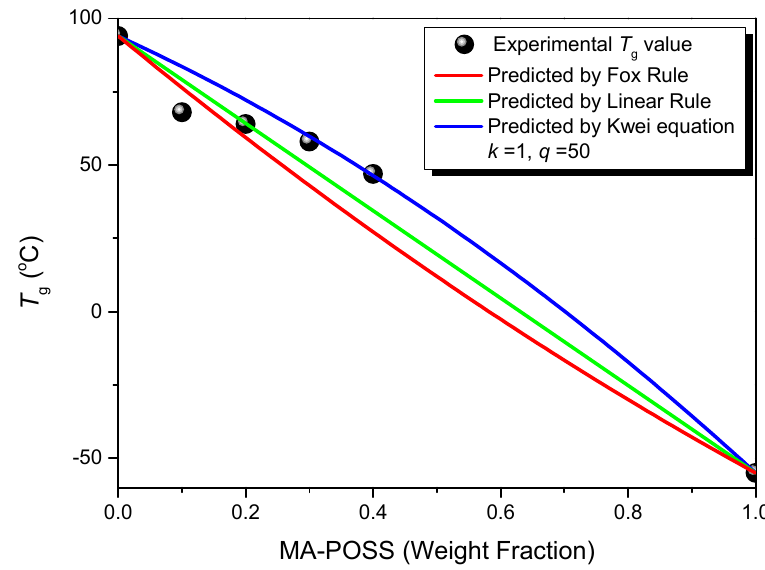
Figure 3. Experimental values of T g of PVC/MA-POSS blends and those predicted by the Fox and linear rules and the Kwei equation.